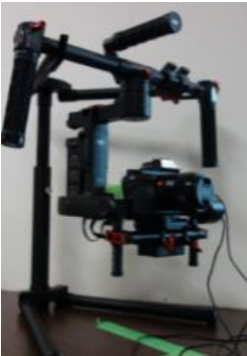
Fig. 4 Gimbal stabilizer DJI RONIN-M